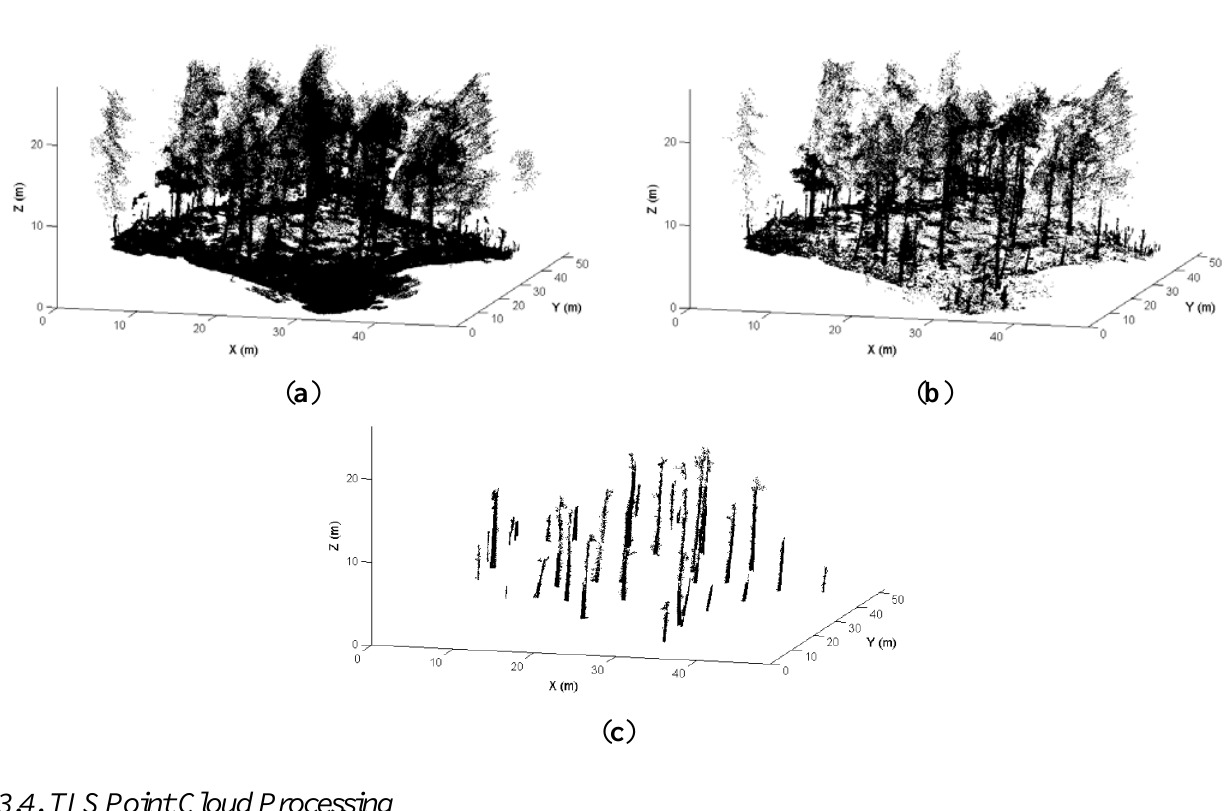
Figure 4. Dataset I: ( a ) The original point cloud data. ( b ) The classified tree stem points according to the G channel response of the points. ( c ) The detected stem points based on the tree mapping